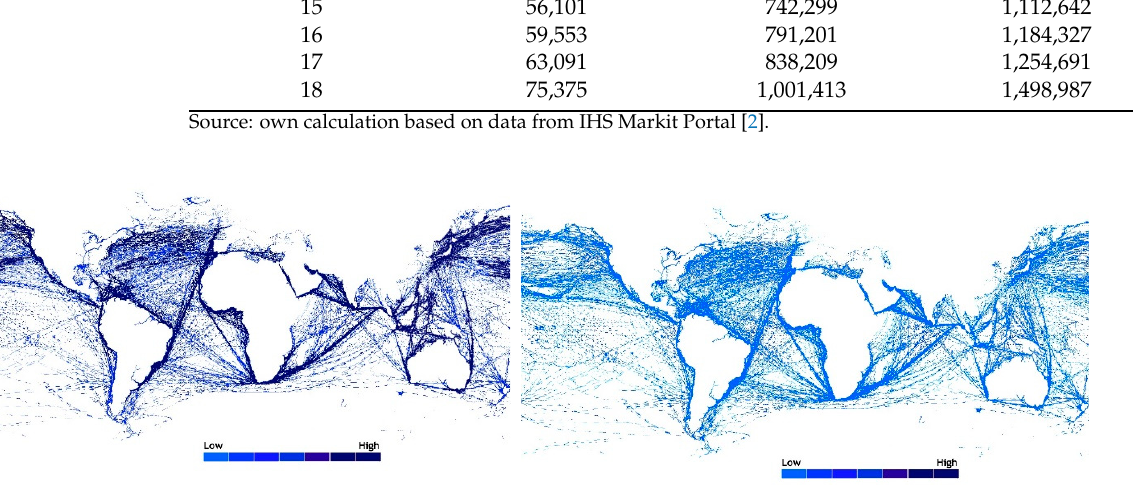
Figure 5. Annual global container shipping NO x emission levels for 2020, (left) base situation for 2018 and (right) estimates using the energy consumption approach, based on extrapolated data from IHS Markit Portal [2].